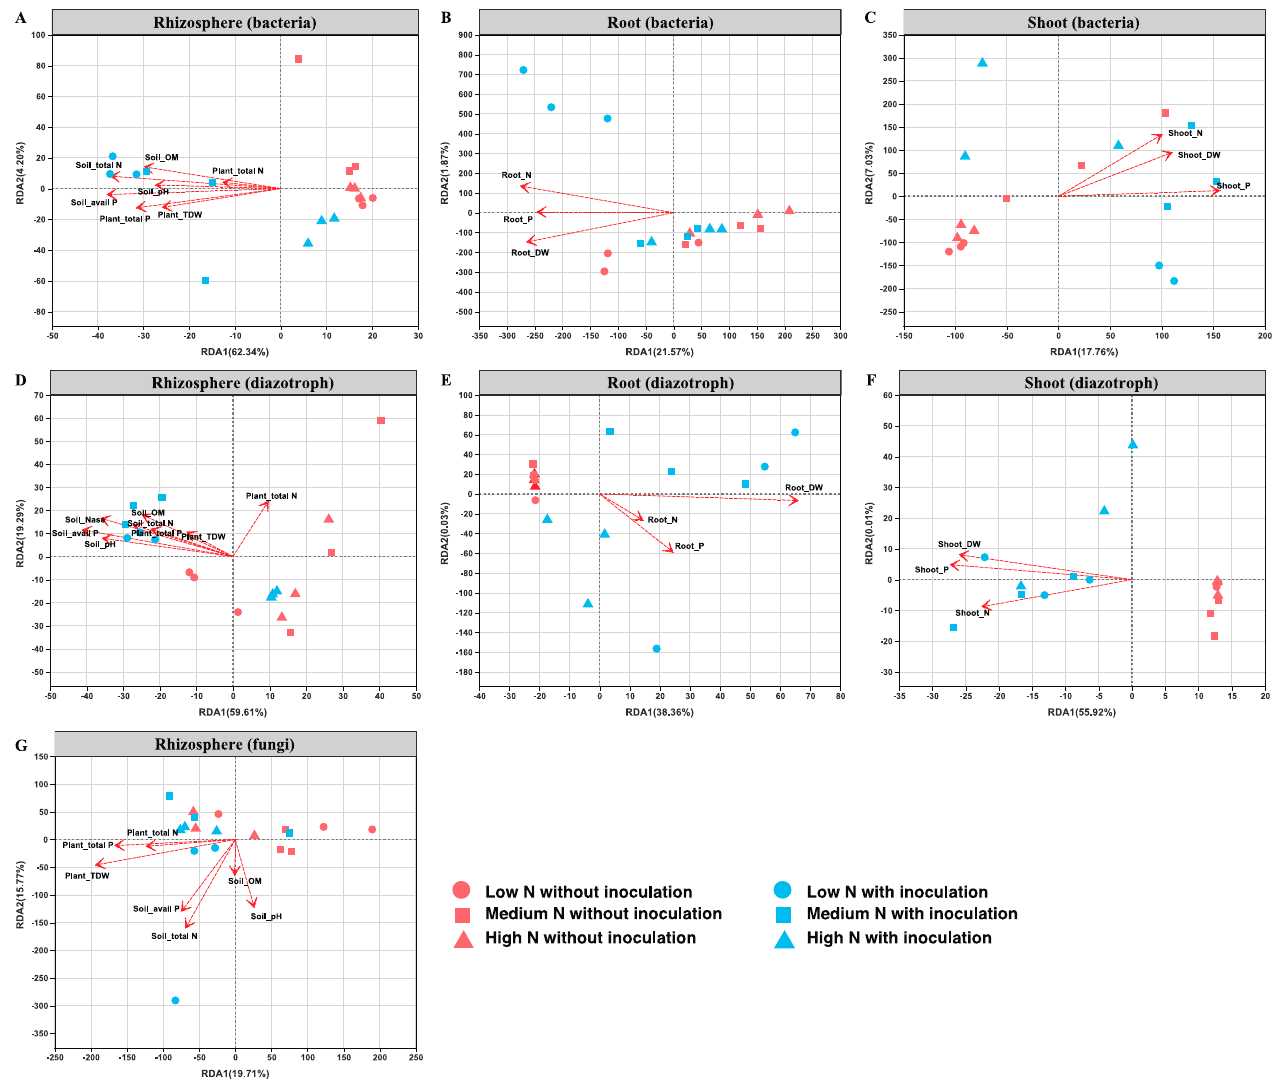
Figure 12. Redundancy analysis (RDA) of the bacterial, diazotrophic and fungal communities in the maize rhizosphere and root/shoot endosphere: ( A ) the rhizosphere bacteria; ( B ) the root endophytic bacteria; ( C ) the shoot endophytic bacteria; ( D ) the rhizosphere diazotrophs; ( E ) the root endophytic diazotrophs; ( F ) the shoot endophytic diazotrophs; ( G ) the rhizosphere fungi. Soil_total N: soil total nitrogen; Soil_avail P: soil available phosphorous; Soil_OM: soil organic matter; Soil_Nase: soil nitrogenase activity; Plant_TDW: plant total dry weight; Plant_total N: plant total nitrogen content; Plant_total P: plant total phosphorous content; Root_DW: root dry weigh; Root_N: root nitrogen content; Root_P: root phosphorous content; Shoot_DW: shoot dry weight; Shoot _N: shoot nitrogen content; Shoot _P: shoot phosphorous content.